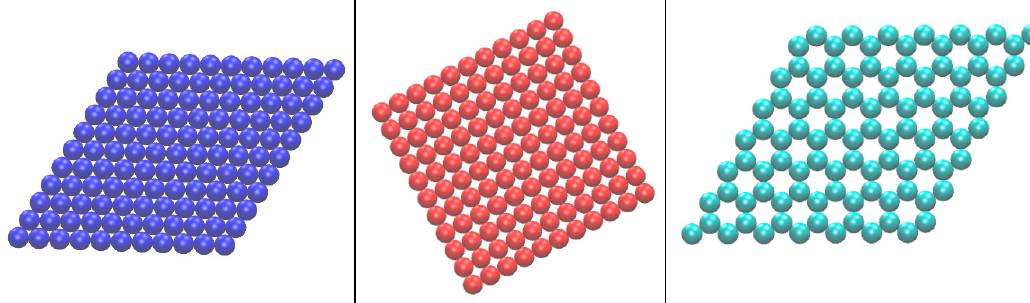
Figure 2. Reference 2-D crystals used for the demonstration of the CCE descriptor. From left to right: triangular (TRI), square (SQU) and honeycomb (HON). The color convention, according to which TRI, SQU, PEN (not shown here) and HON sites are represented in blue, red, green and cyan is used throughout the present manuscript. Image created with the VMD software. Each figure panel is also available as stand-alone image in 3-D, interactive format in the Supplementary Material.